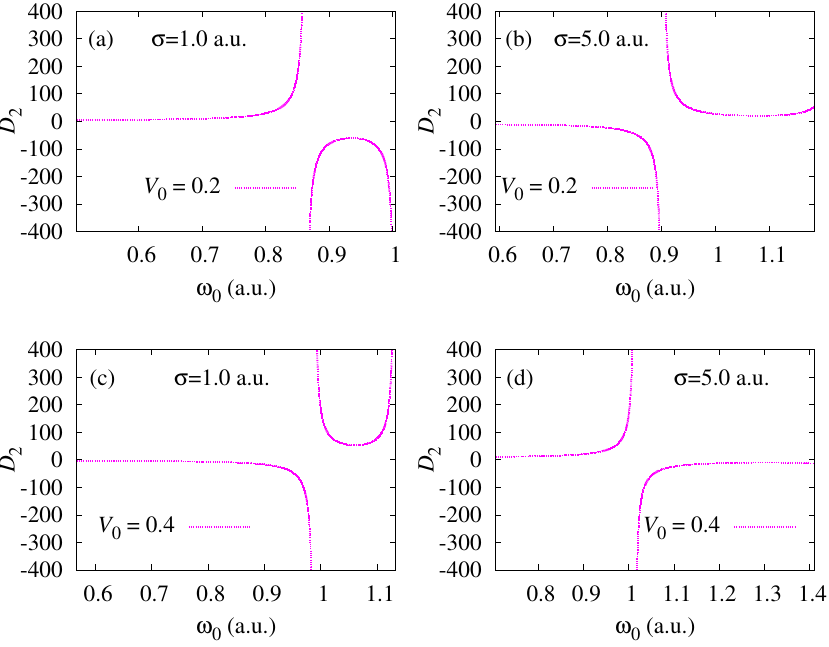
Figure 4. Variation of two-photon 1 s → 3 d transition probability amplitude with frequency of incoming photons, ω 0 , for ( a ) V 0 = 0.2 a.u. and σ = 1.0 a.u.; ( b ) V 0 = 0.2 a.u. and σ = 5.0 a.u.; ( c ) V 0 = 0.4 a.u. and σ = 1.0 a.u.; ( d ) V 0 = 0.4 a.u. and σ = 5.0 a.u.